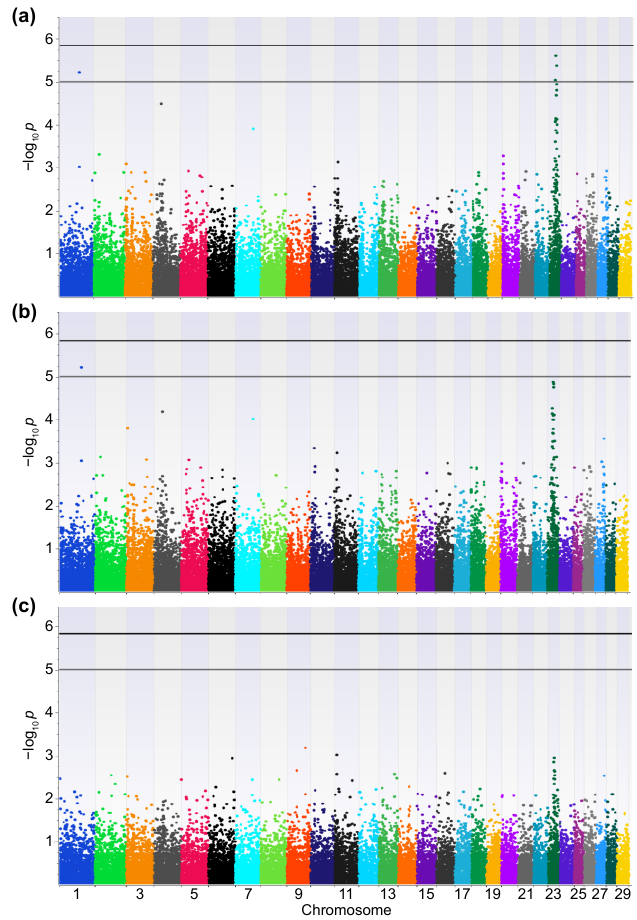
Figure 2. Manhattan plots between cattle with high and low bovine leukemia virus proviral loads. Manhattan plots for the Additive ( a ), Dominant ( b ), and Recessive models ( c ) are depicted. The number of chromosomes and the negative logarithm of the association p -values are displayed along the x- and y-axes, respectively. p -values were calculated with Fisher’s exact test, and the bold and thin lines indicate the genome-wide significance ( p = 1.449 × 10 − 6 ) and the moderate thresholds ( p = 1.0 × 10 − 5 ), respectively. Table 1. Single-nucleotide polymorphisms (SNPs) with significant difference as a result of genome- wide association study.